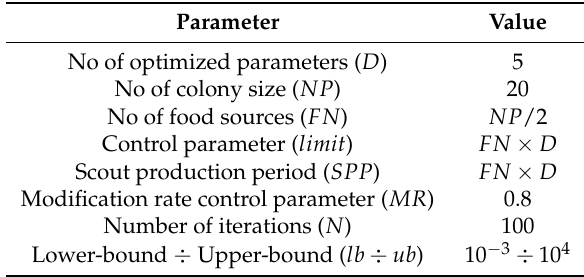
Table 2. Artificial Bee Colony